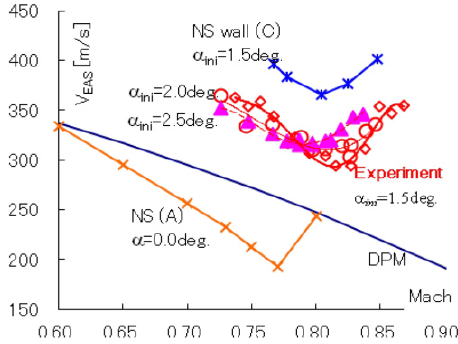
Figure 18. Flutter (LCO)